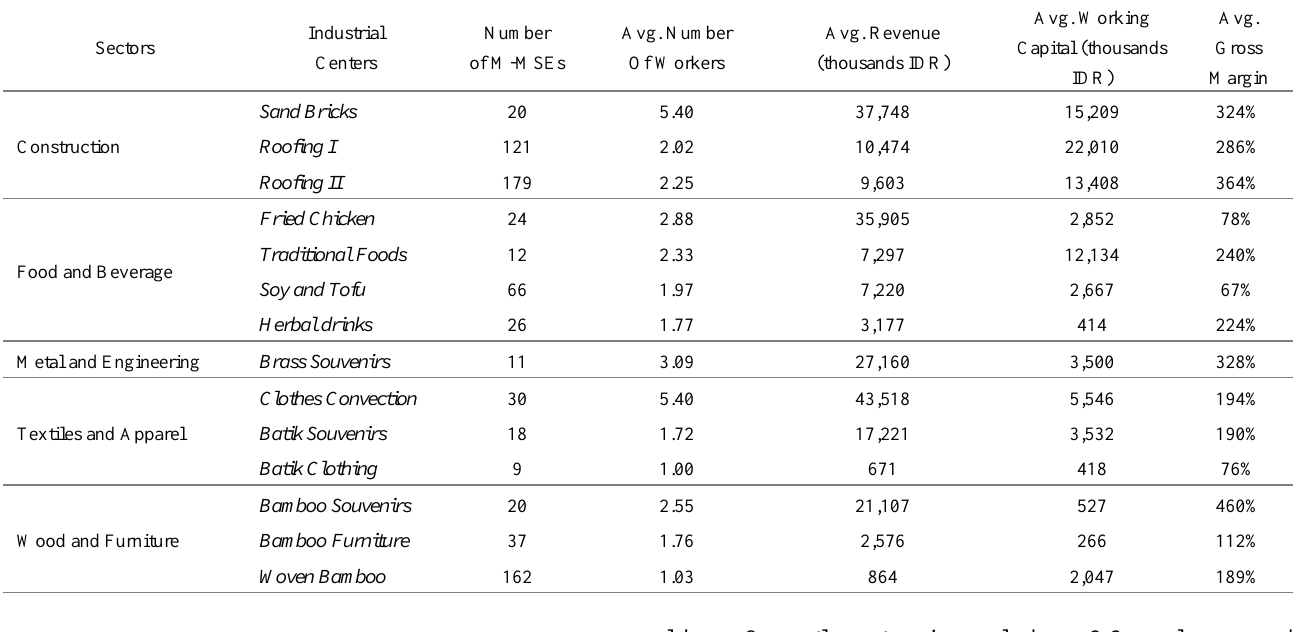
Table 2. Performance of the Industrial Centers